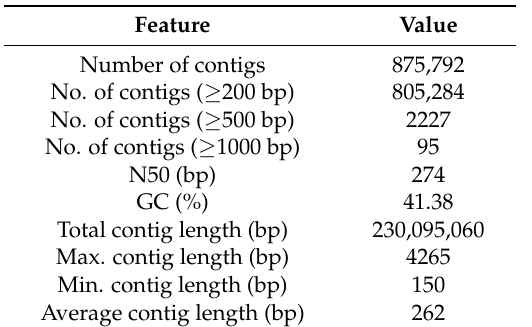
Table 2. Summary statistics of the restriction-associated DNA (RAD) tags